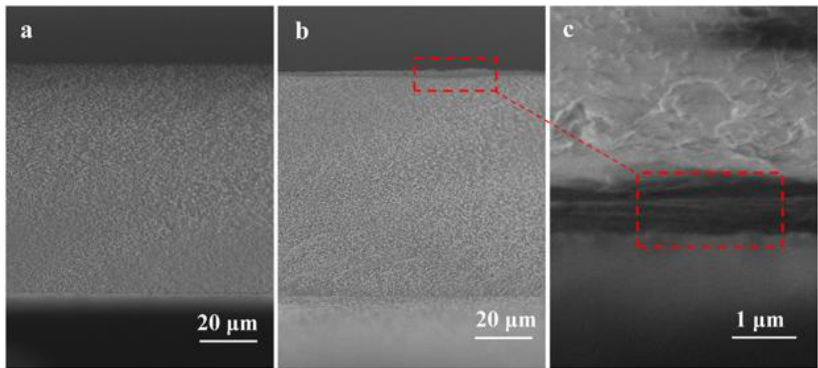
Figure 9. SEM cross-sections of: ( a ) original CJMA-2 AEM, ( b ) modified CJMA-2-7.5 AEM, and ( c ) high magnification of the modified membrane. Reproduced with permission from [37].